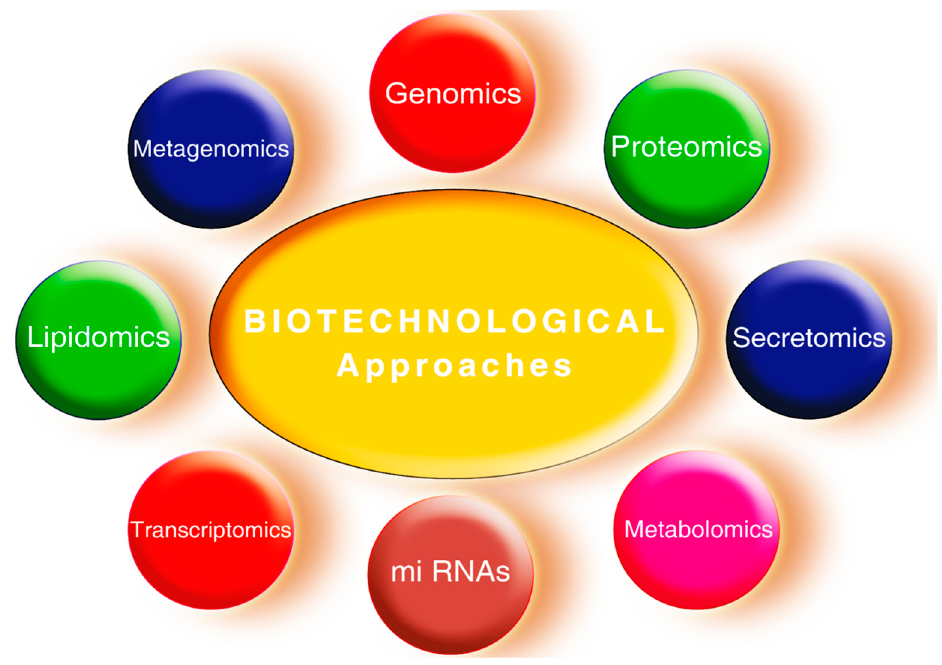
Figure 3. Different omics approaches for crop improvement.